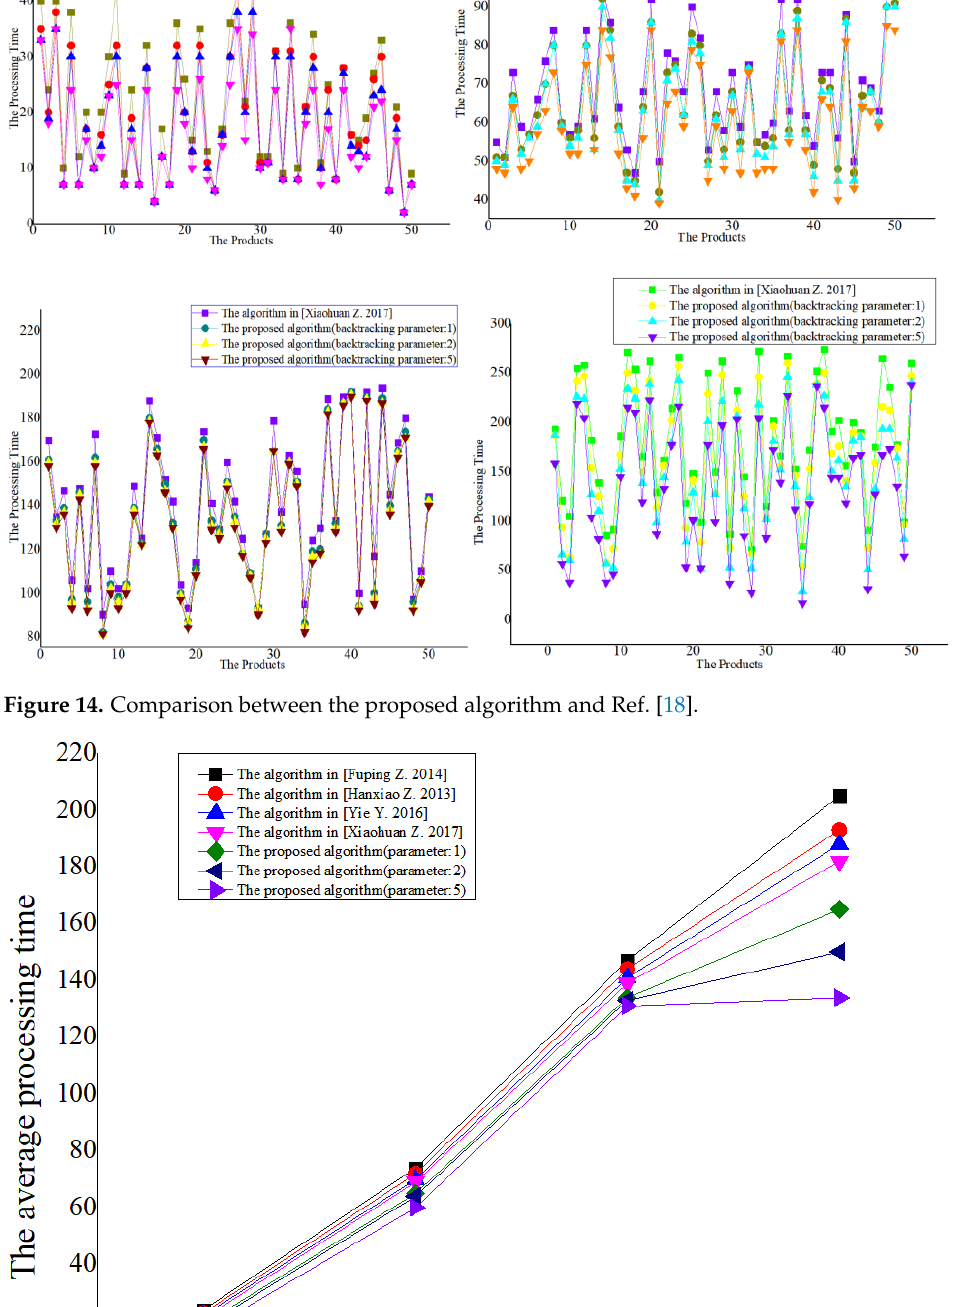
Figure 15. Comparison of the average scheduling results of each algorithm [15 – 18].